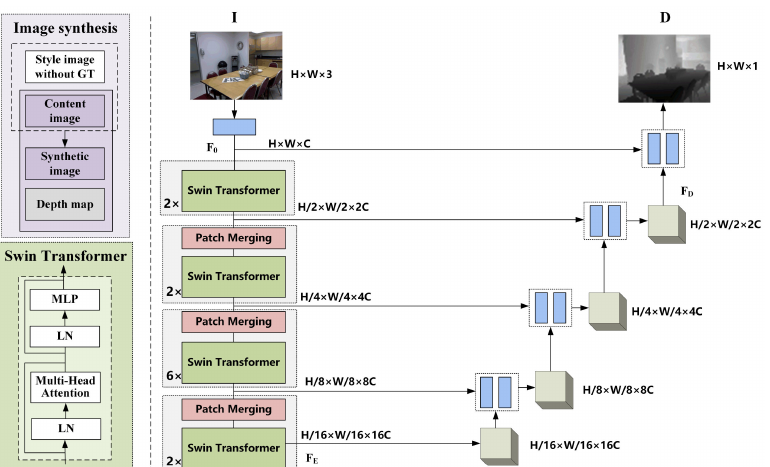
Figure 3. Architecture of image-depth estimation. The encoder is composed of Swin Transformer [29] and the decoder consists of upsampling and convolutional